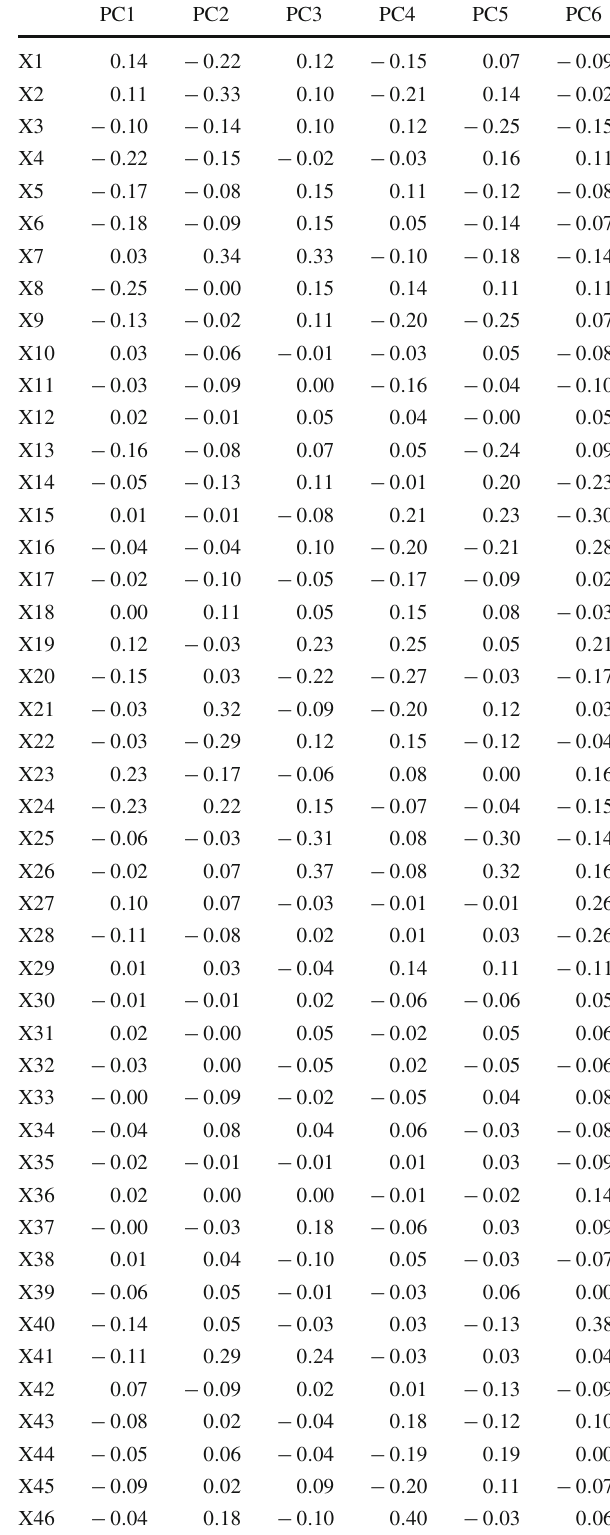
Table 5 Rotation matrix for projection on the first 6 PCs of PCA1 where X1 corresponds to eigenvector set 1 and so